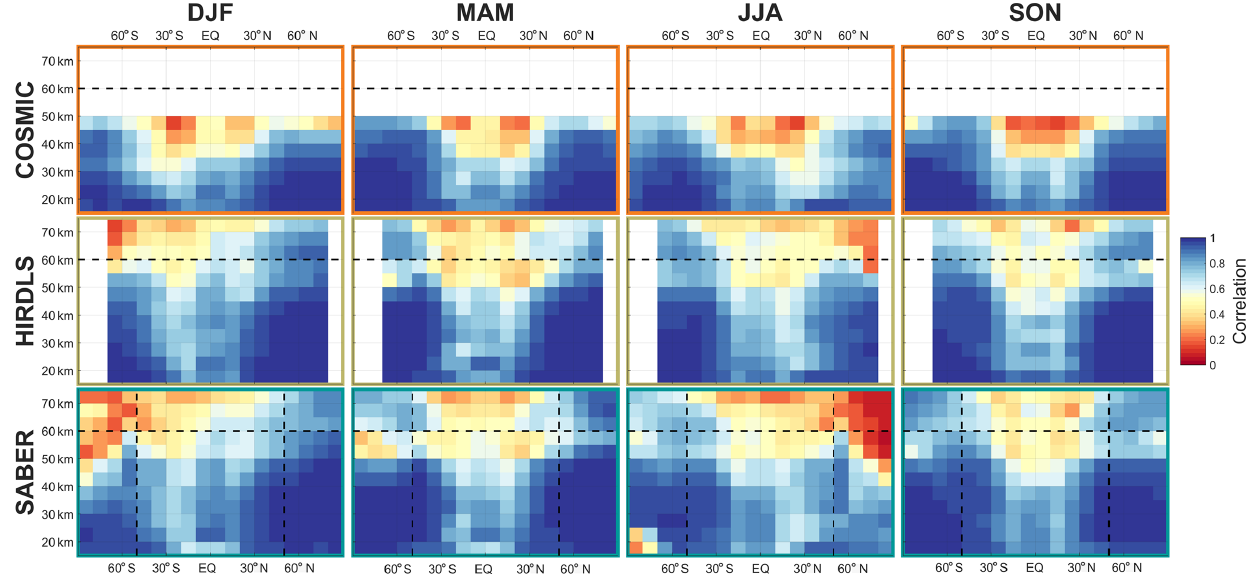
Figure 11. Correlations between multi-reanalysis mean (MRM) sampled temperatures and each instrument, decomposed by latitude, altitude and season. Dashed line at 60km in altitude indicates the approximate height of the transition from a six-reanalysis MRM to a two-reanalysis MRM; dashed lines at 50 ◦ S and 50 ◦ N indicate the boundary of full and partial SABER coverage. See Supplement Figs. S1–S6 for individual satellite–reanalysis comparisons.